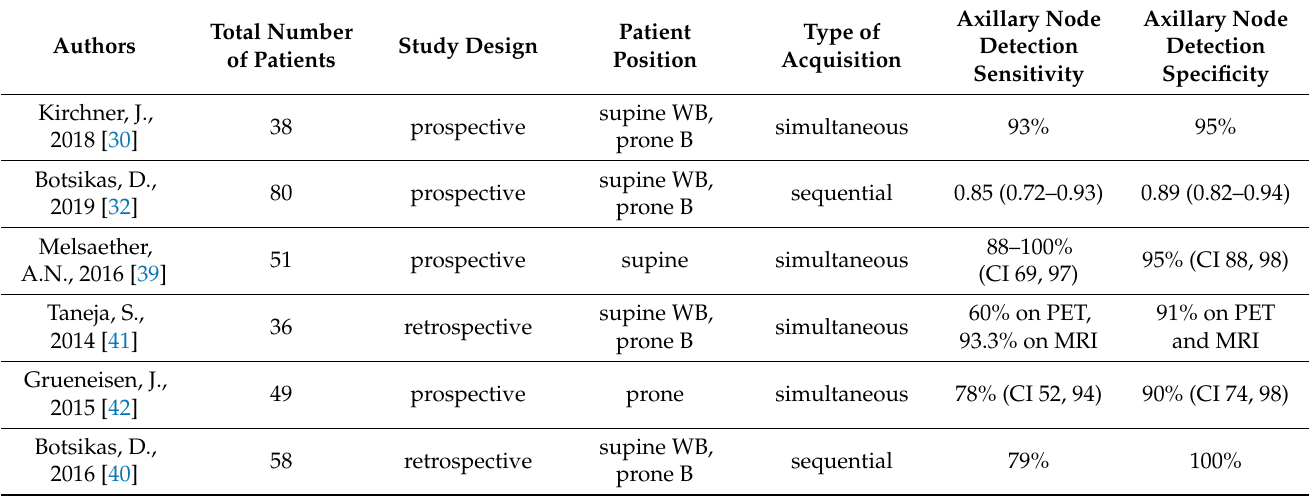
Table 2. Previous studies on PET/MRI evaluating the axillary status in breast cancer (NA = not available, WB = whole body PET/MRI, B = breast